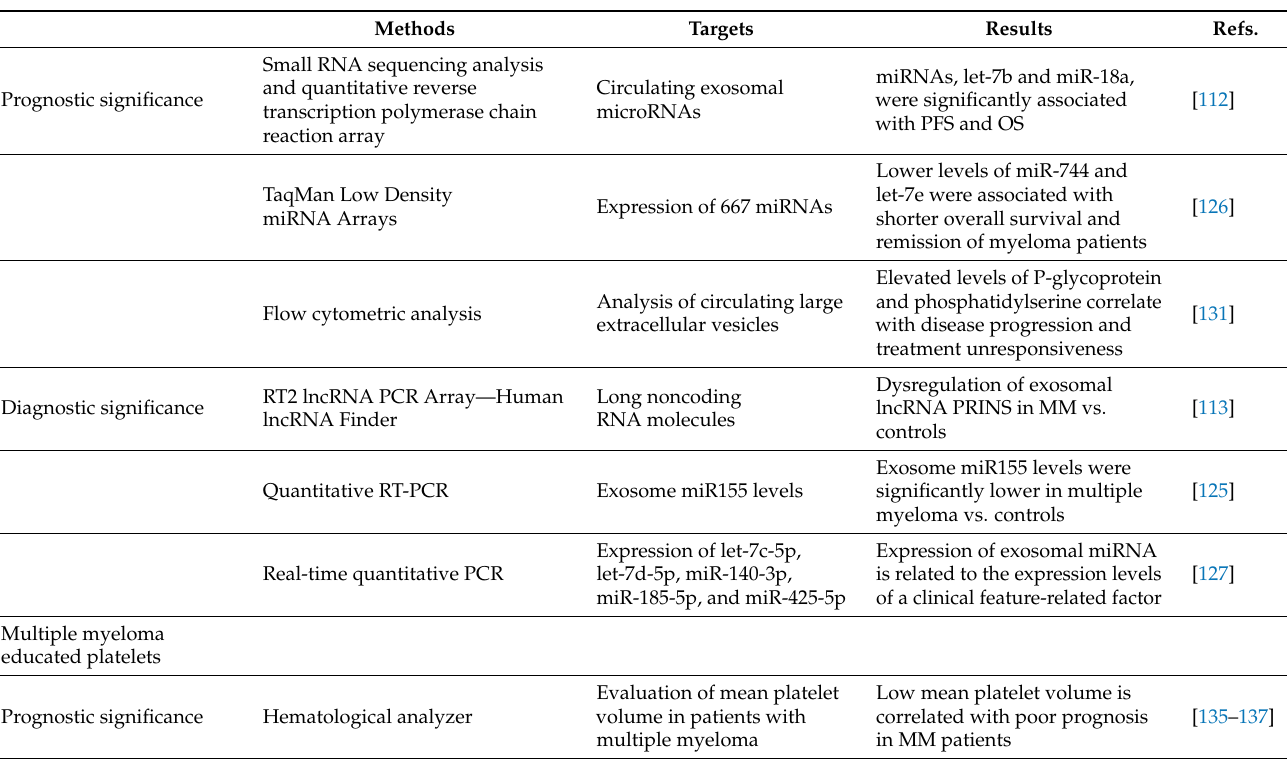
Figure 2. Tumour educated platelet in liquid biopsy. Table 3. Studies on exosomes and educated platelets.